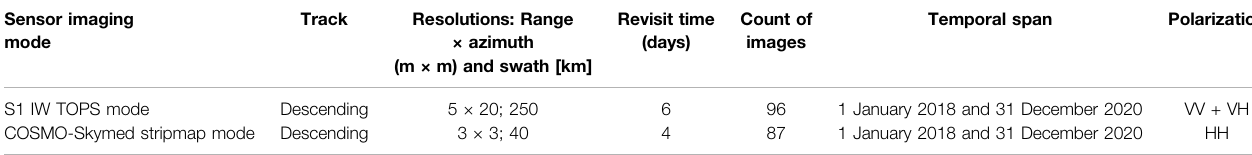
TABLE 1 | Characteristics of SAR images used for the present research. Sensor imaging mode